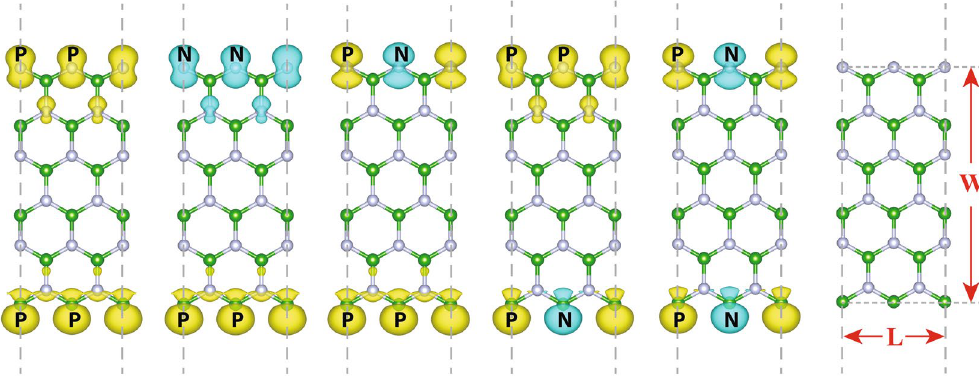
Figure 1. Schematic representations of the five edge magnetic configurations studied for stoichiometric zigzag BN nanoribbons. Each state is denoted as a combination of two pairs of positive ( p ) and negative ( n ) spin moments, according to the magnetization on the B and N edges, respectively.